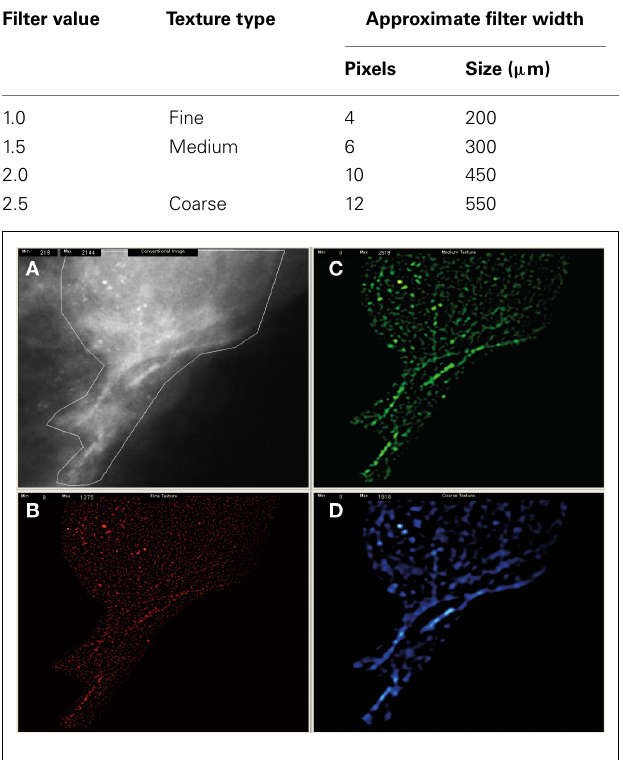
Table 1 | Filter sigma value, texture type, and the corresponding width of the filter (pixels and